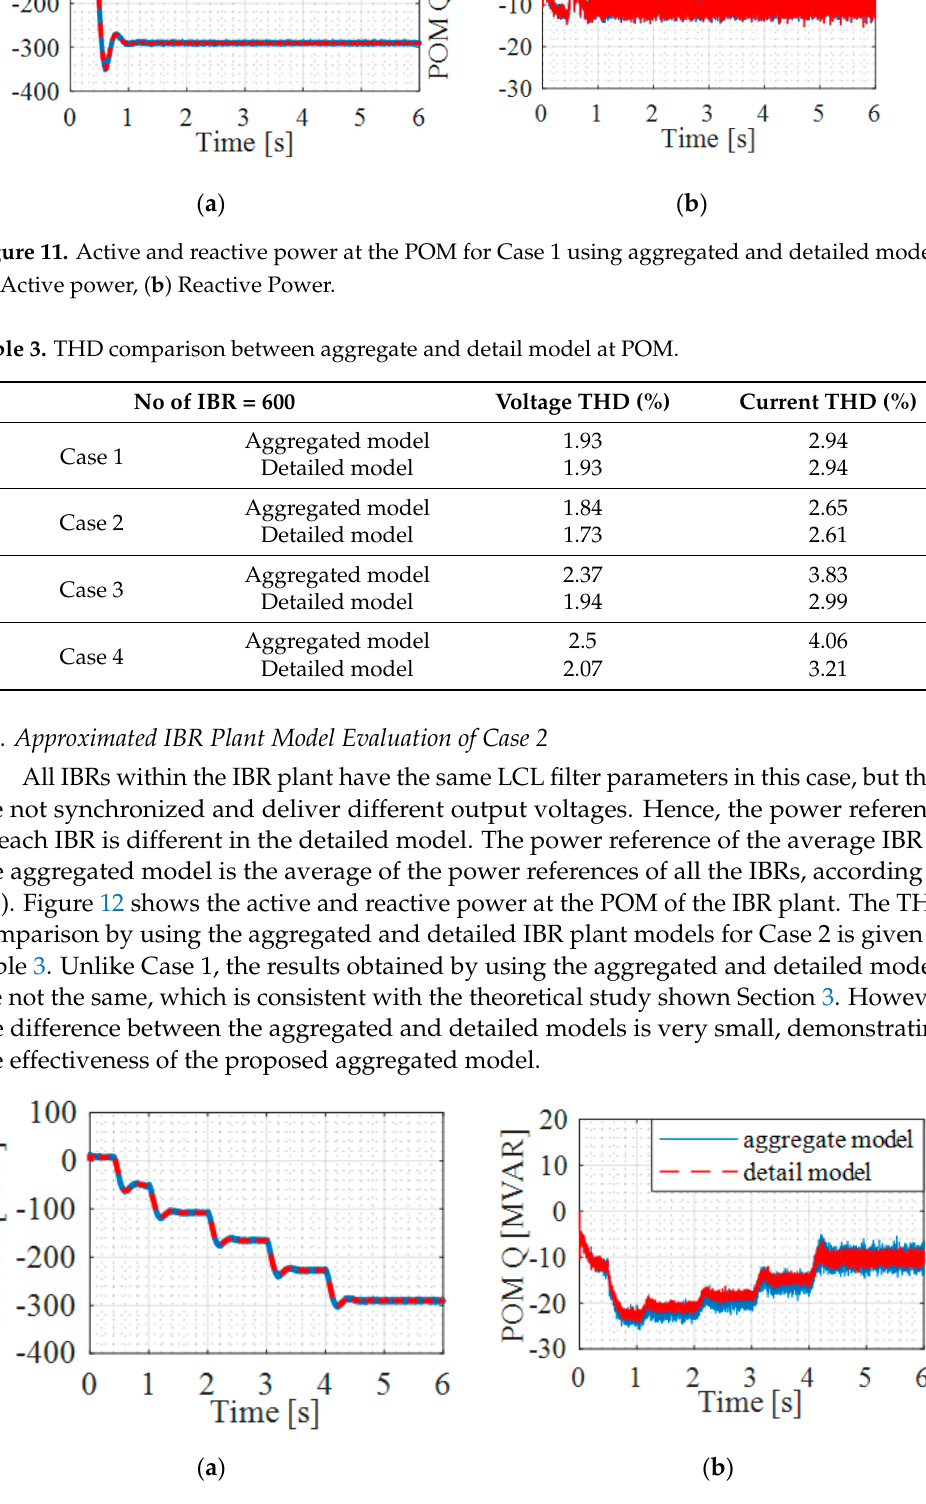
Figure 12. Active and reactive power at the POM for Case 2 using aggregated and detailed models: ( a ) Active power, ( b ) Reactive Power. ( a ) Active power, ( b ) Reactive